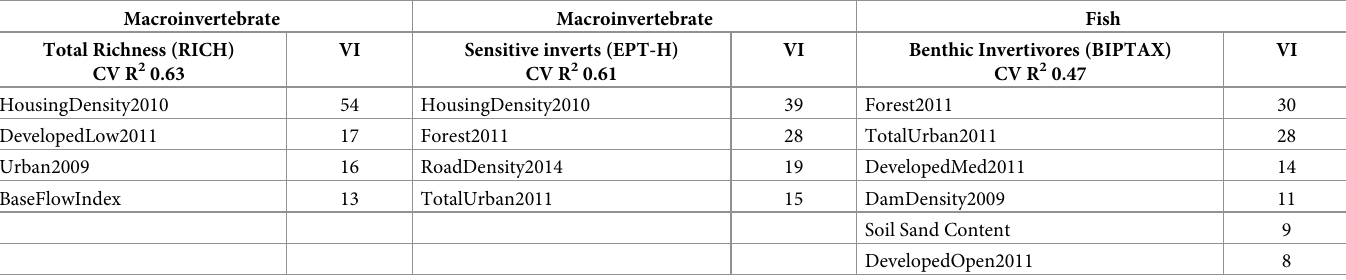
Table 2. Comparison of explanatory variables for BRT models for macroinvertebrate and fish metrics for geospatial variables; variables are presented in descending order of variable importance (VI) in each model. See S3 Table for variable sources and definitions. Macroinvertebrate Macroinvertebrate Fish Total Richness (RICH) CV R 2